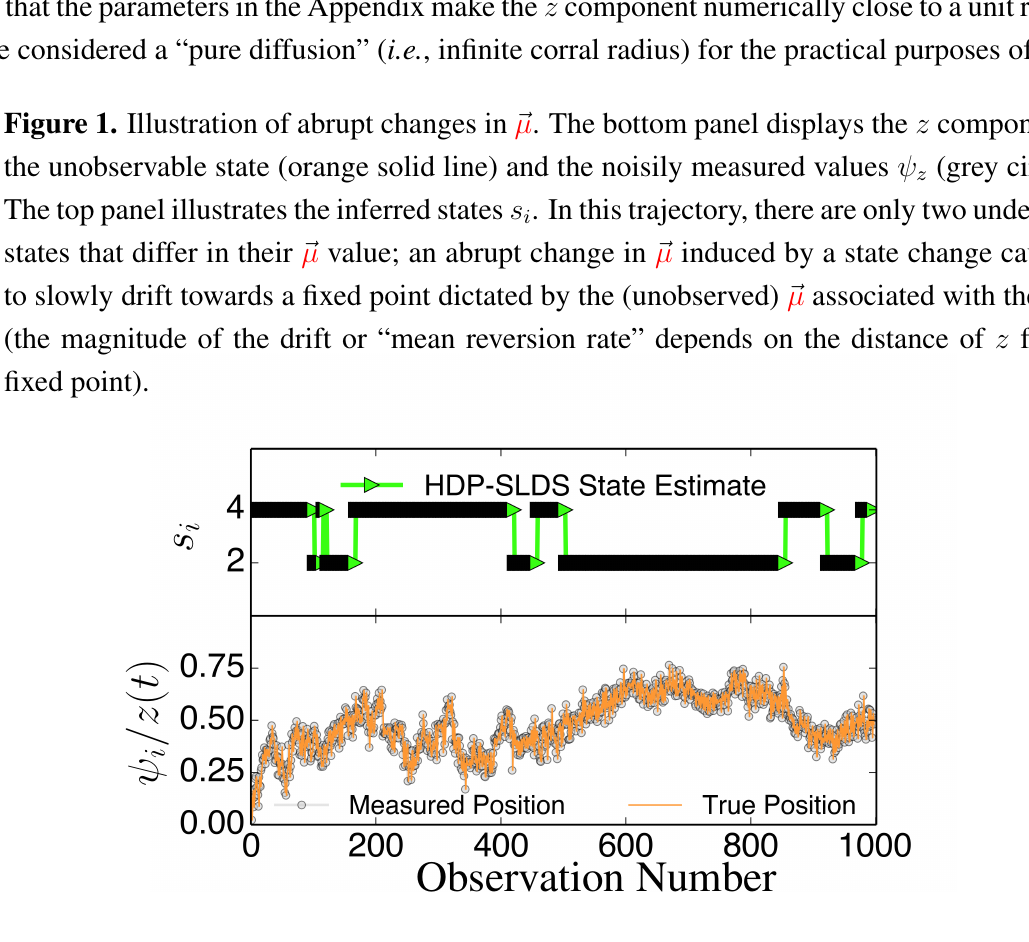
the unobservable state (orange solid line) and the noisily measured values ψ